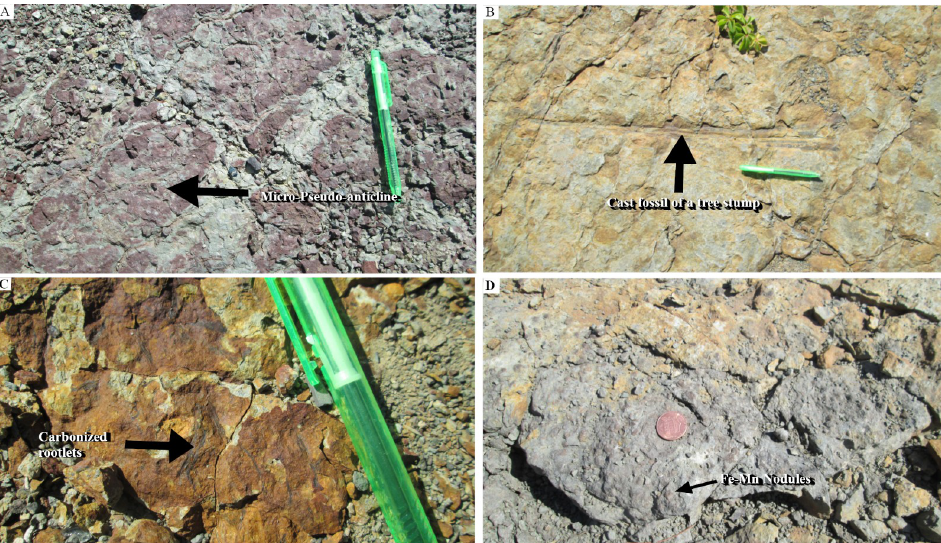
Fig 17. Main features of the paleosol underlying hydromorphic paleosol. The paleosol underlying hydromorphic- paleosol was exposed by the quarrying at the local-depression. The presence of the fossilized roots, stems, blocky peds, and pseudo-anticlines as well as its stratigraphic position (underlying light-gray hydromorphic paleosol) made it correlatable with paleoforest at the C-D section. (A) Mini-pseudo-anticlines with oxidized microhigh (weak-red) and reduced microlows (light-olive green): Located between sections I-J and K-L. (B) A cast-fossil of a stem: Note the broad- base and the tapering of the stem. (C) Some carbonized impressions of the branched rootlets. (D) Two hydromorphic features, the yellowish-brown coloration of the surface paleosol (as a result of pyrite oxidation) and iron-manganese in the subsurface paleosol. Note that the paleosol features such as pyrite oxidation, iron-manganese nodules, and carbonized rootlets all indicating that ponding happened at this location, as a result of the impervious subsurface soil as were evident from the presence of the iron-oxide coloration of the micro-pseudoanticline in the subsurface paleosol.